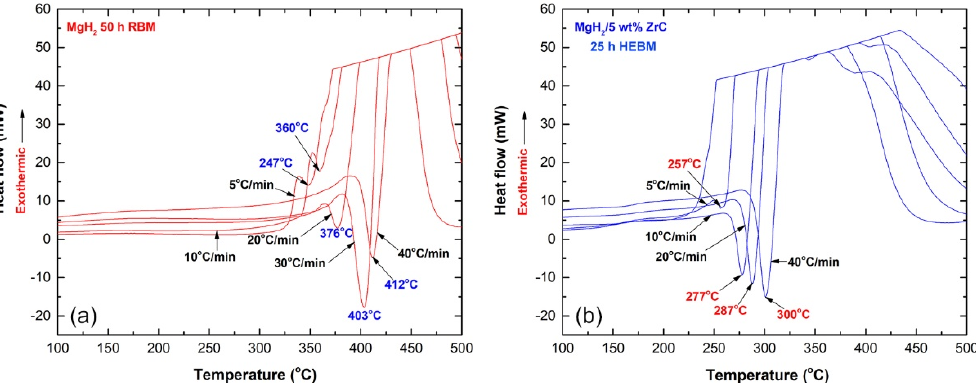
Figure 8. DSC thermograms conducted at heating rates of 5, 10, 20, 30, and 40 °C/min for ( a ) MgH 2 powders, obtained after 50 h of RBM, and ( b ) mechanically mixed MgH 2 /5 wt% ZrC nanocomposite powders obtained after 25 h of HEBM.